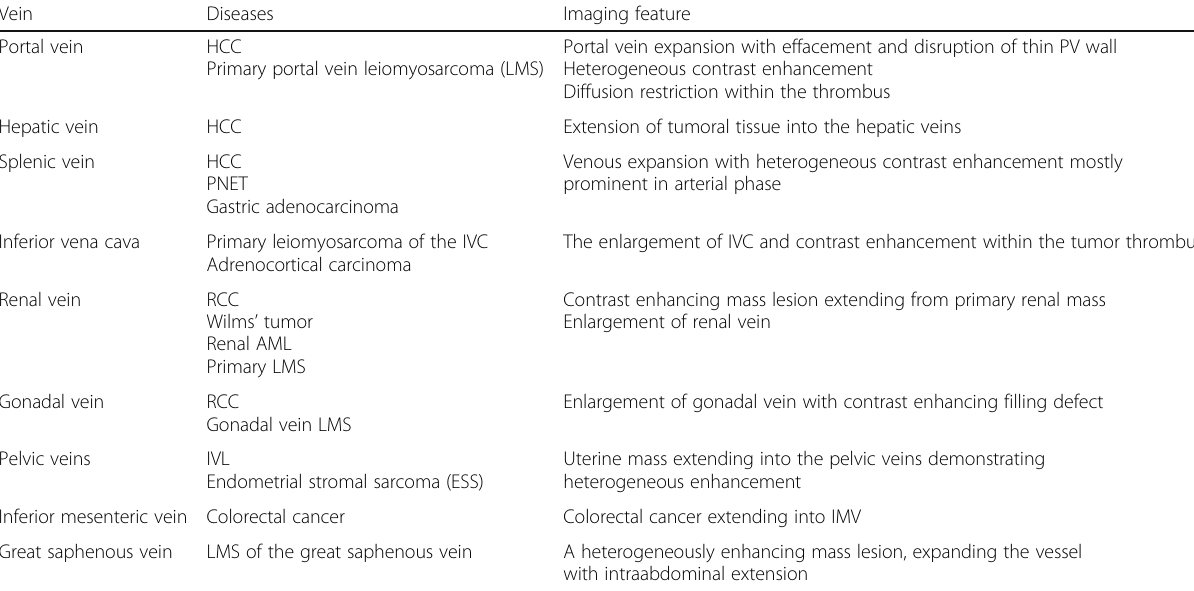
Table 1 Clinical and imaging features of tumoral thrombus Vein Diseases Imaging